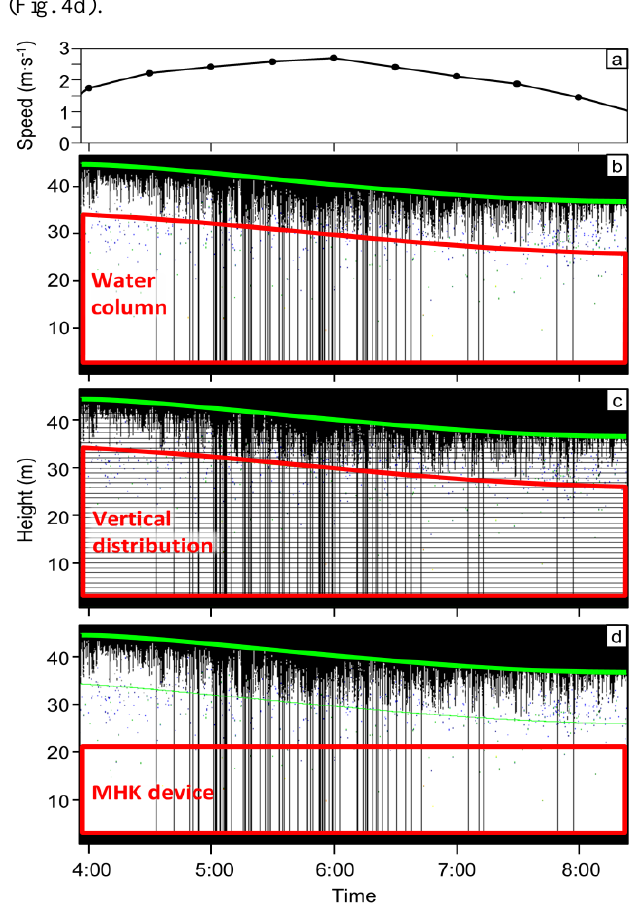
Fig. 4 Data from one ebb tide from 3:56 to 8:23 UTC on 9 December 2015. (a) Current speed from 16-17 m above the sea floor. (b-d) The three water column partitions used in analysis: (b) entire water column, defined as the acoustic nearfield to the 10-m depth line; (c) 1-m layers for vertical distribution analysis; (d) layer that encompasses depths spanned by the MHK device installed in 2016. Height is measured upward from the sea floor. Vertical black lines are pings omitted due to entrained air (Fig.